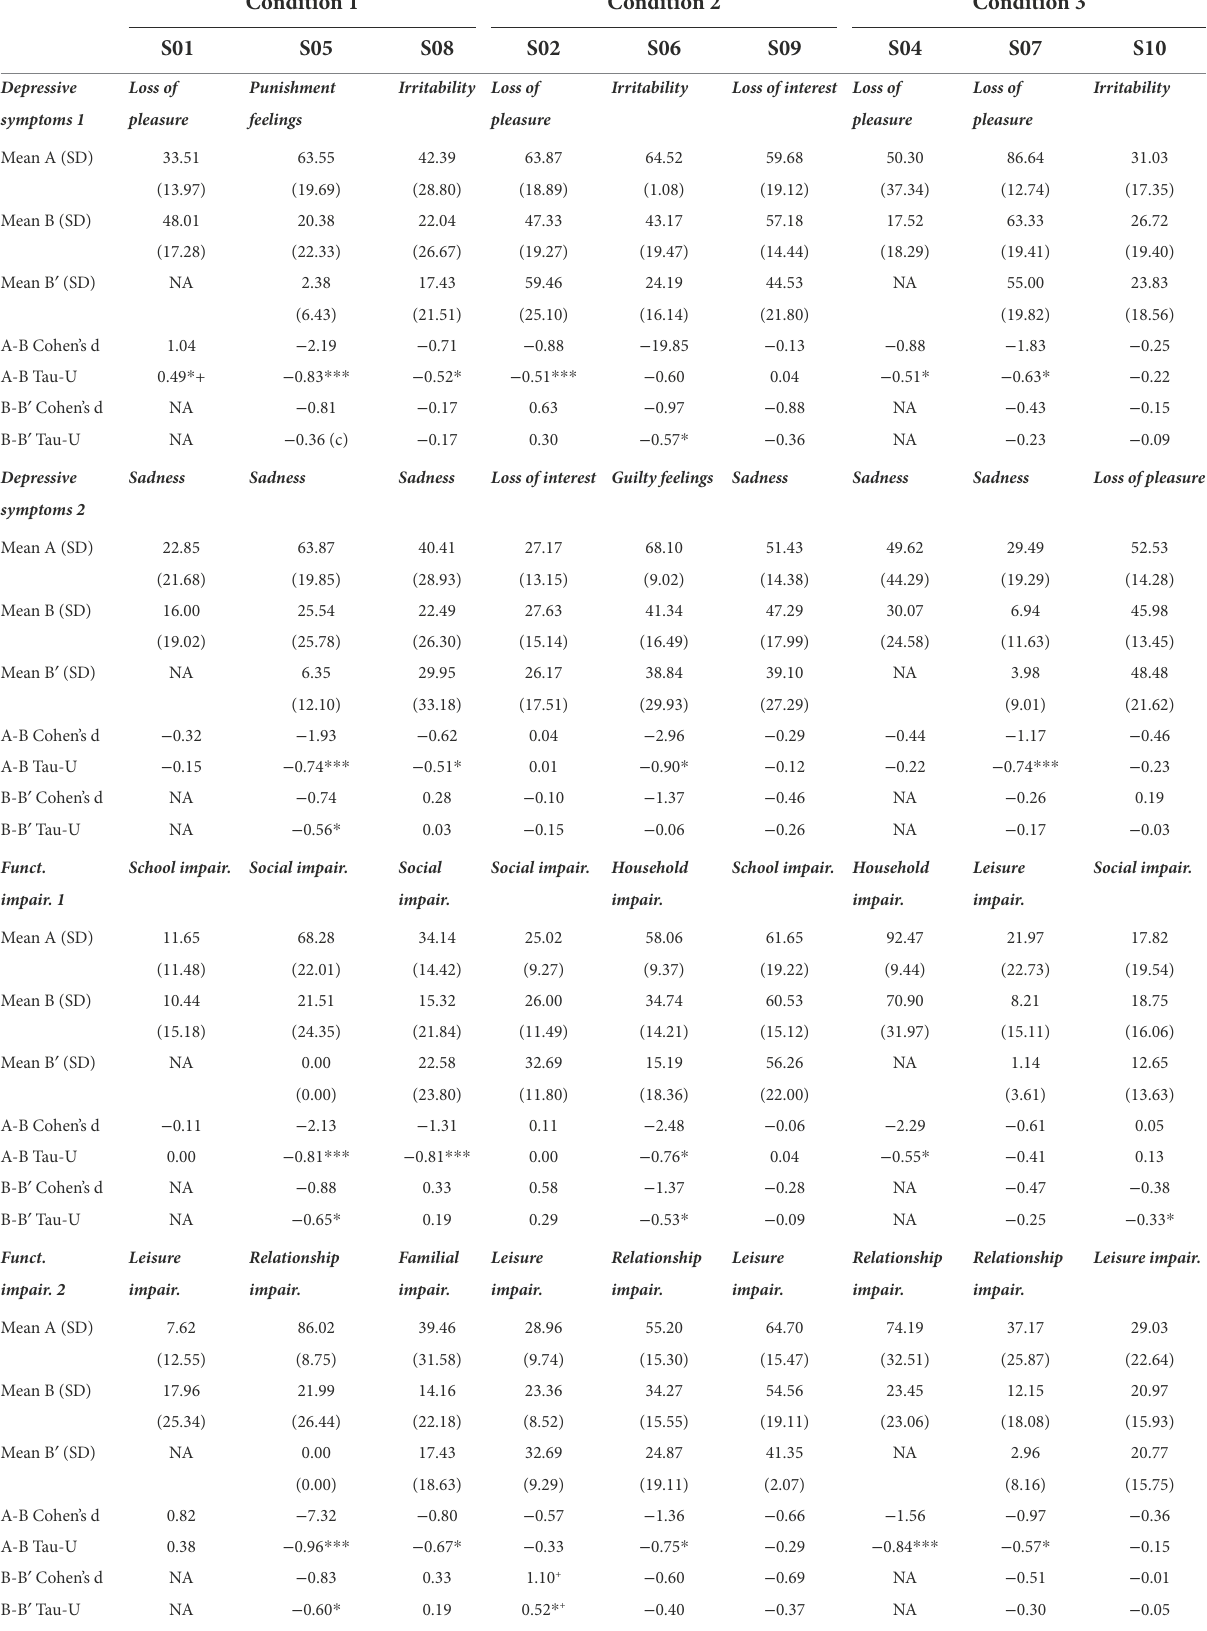
TABLE 4 Means, standard deviations, Tau-U and Cohen’s d scores for generic mental health measures for all participants across phases. Condition